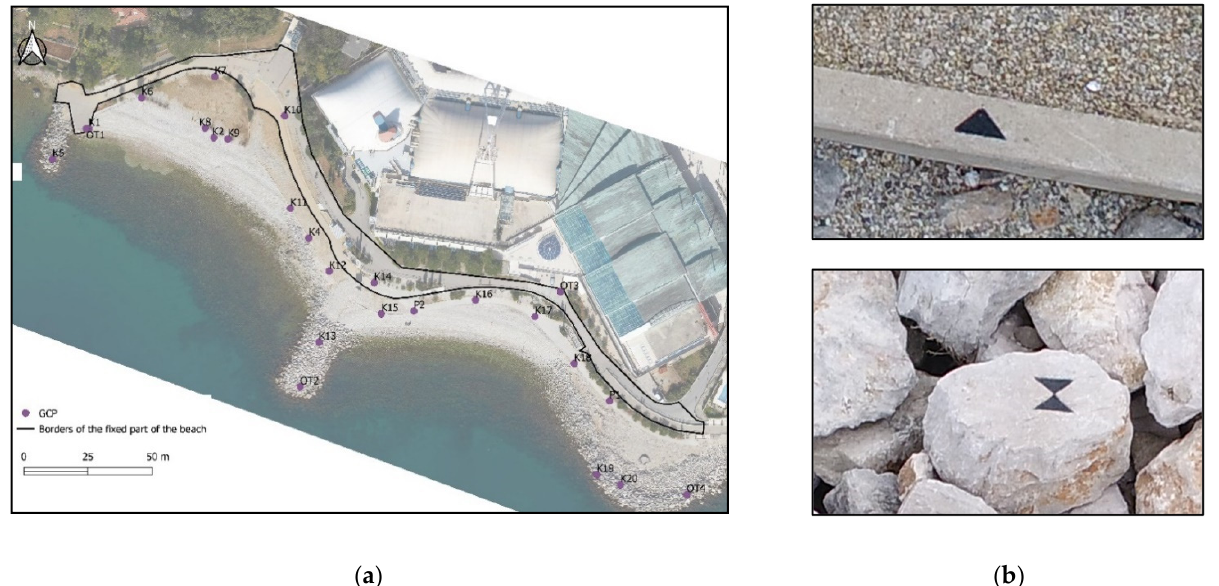
Figure 3. ( a ) Study site with marked locations of ground control points (K1, K2, K4–K20, P1,